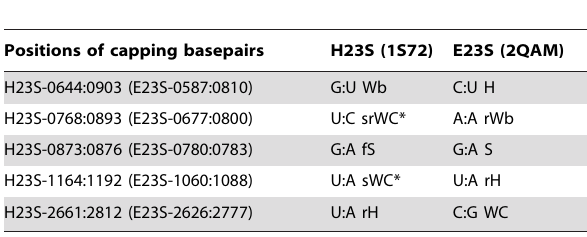
Table 4. Capping basepairs in different conformations in different crystal structures { .